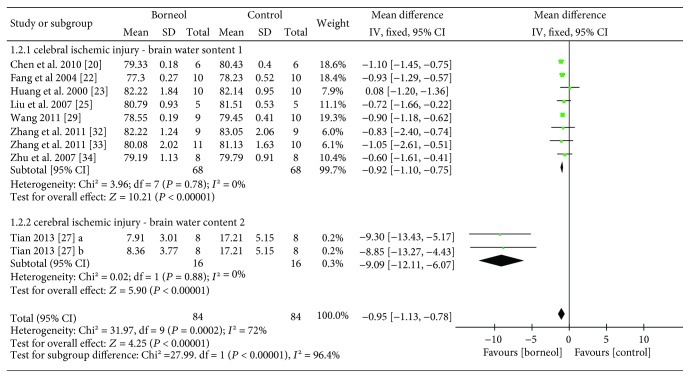
The forest plots: the borneol group versus the control group on brain water content under pathological conditions.